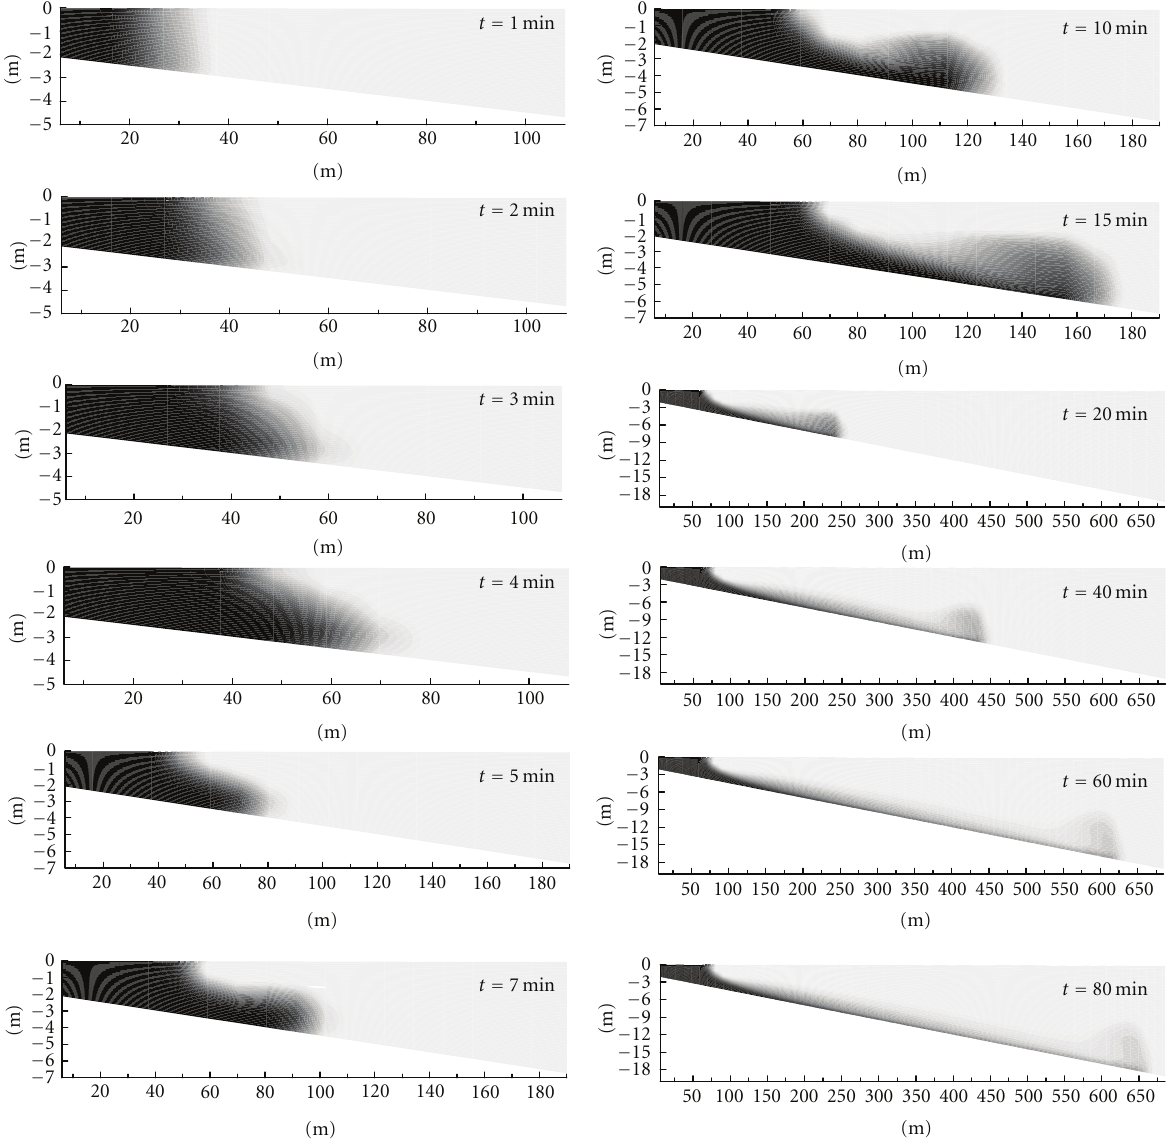
Figure 7: Sequential snapshots of density distributions computed at selected time instants (note that the x -axis scales are di ff erent in